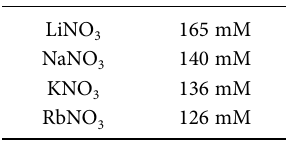
Table 1. Coagulation concentrations of some (1-1) electrolytes for AgI sols. Data by Kruyt and Klompé (1942).